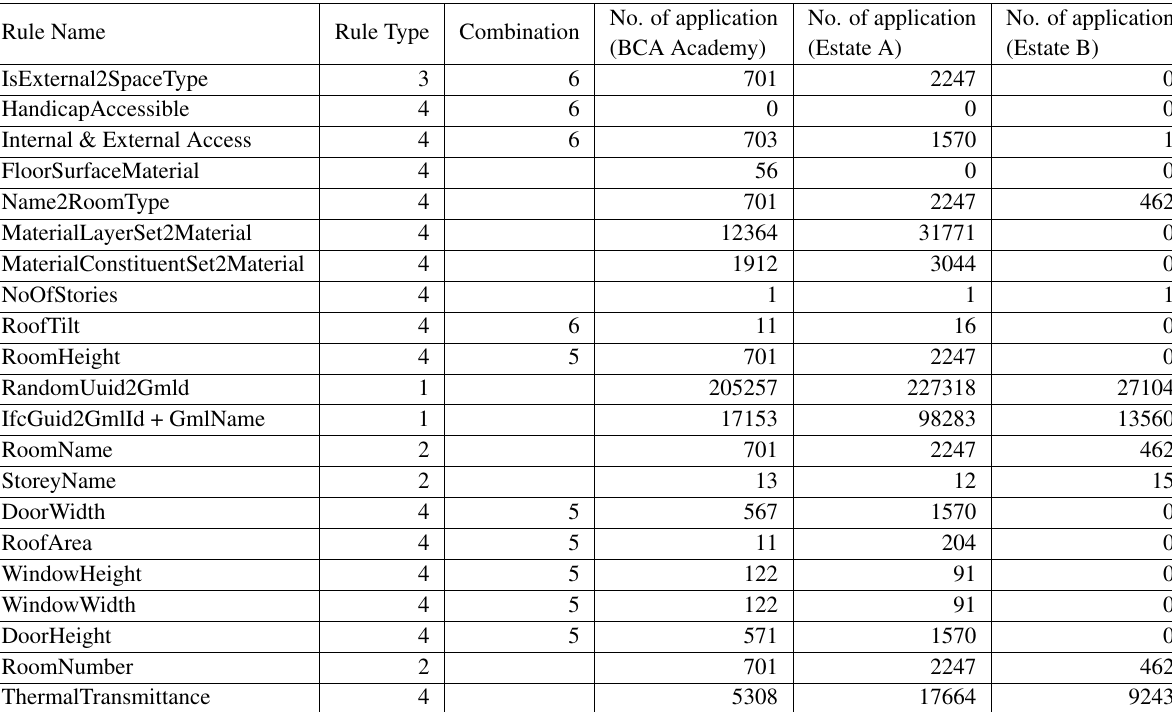
Table 2. Table of each rule, its corresponding type and how often each rule is applied in the BCA Academy Model, Estate A Model and Estate B